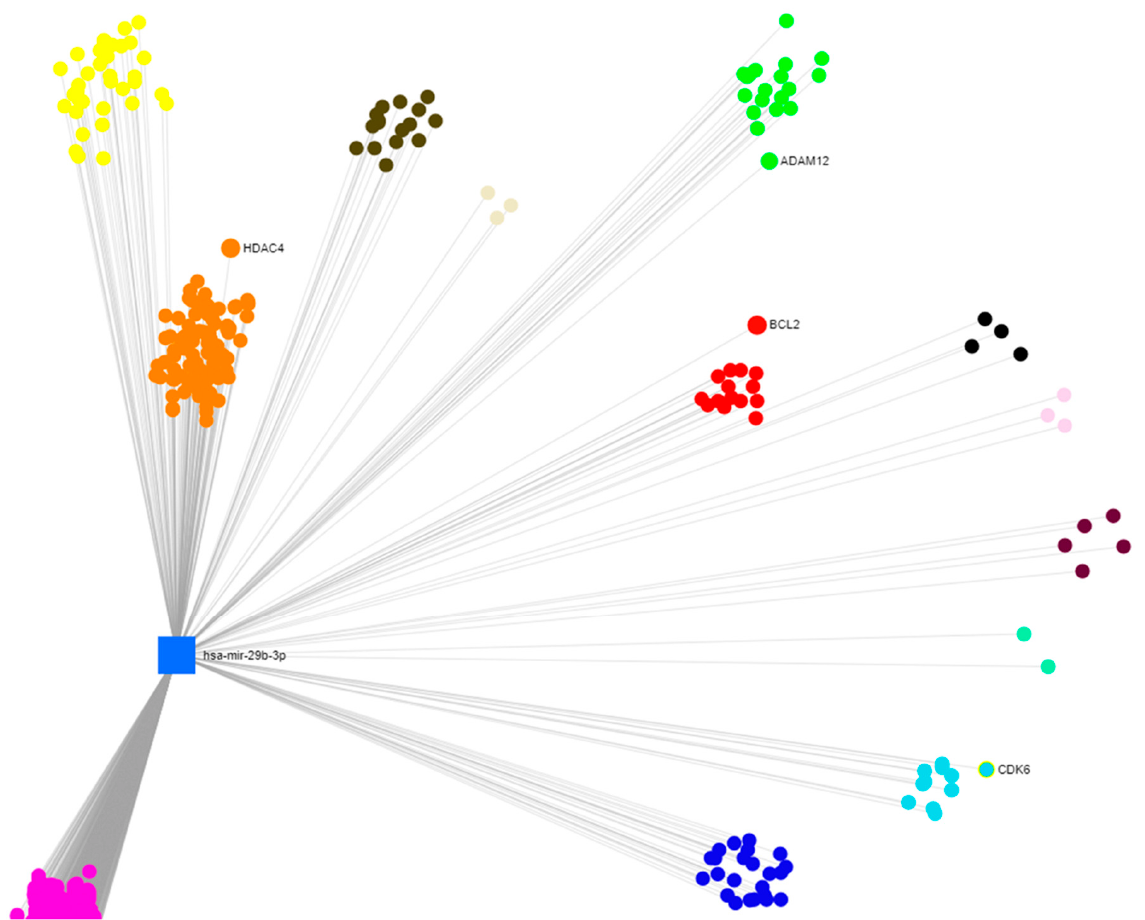
Figure 5. Enrichment analysis for miR-29b-3p obtained from miRNet. The central node is miR-29b-3p, connected to his target genes, grouped according to their integration in one (or more than one) functional pathway identified by the various software. Blue nodes: pathway in cancer (KEGG software); green nodes: signaling by EGFR (Reactome software); orange: regulation of cell differentiation ; yellow: negative regulation of apoptotic processing (GO:BP software); light blue nodes: pathway in cancer and regulation of cell differentiation ; red nodes: pathway in cancer, regulation of cell differentiation and negative regulation of apoptotic processing ; purple nodes: pathway in cancer and negative regulation of apoptotic processing ; black nodes: pathway in cancer, signaling by EGFR, regulation of cell differentiation and negative regulation of apoptotic processing ; darker green nodes: pathway in cancer, signaling by EGFR and regulation of cell differentiation ; light pink nodes: pathway in cancer, signaling by EGFR and negative regulation of apoptotic processing ; beige: signaling by EGFR and regulation of cell differentiation ; brown nodes: regulation of cell differentiation and negative regulation of apoptotic processing .